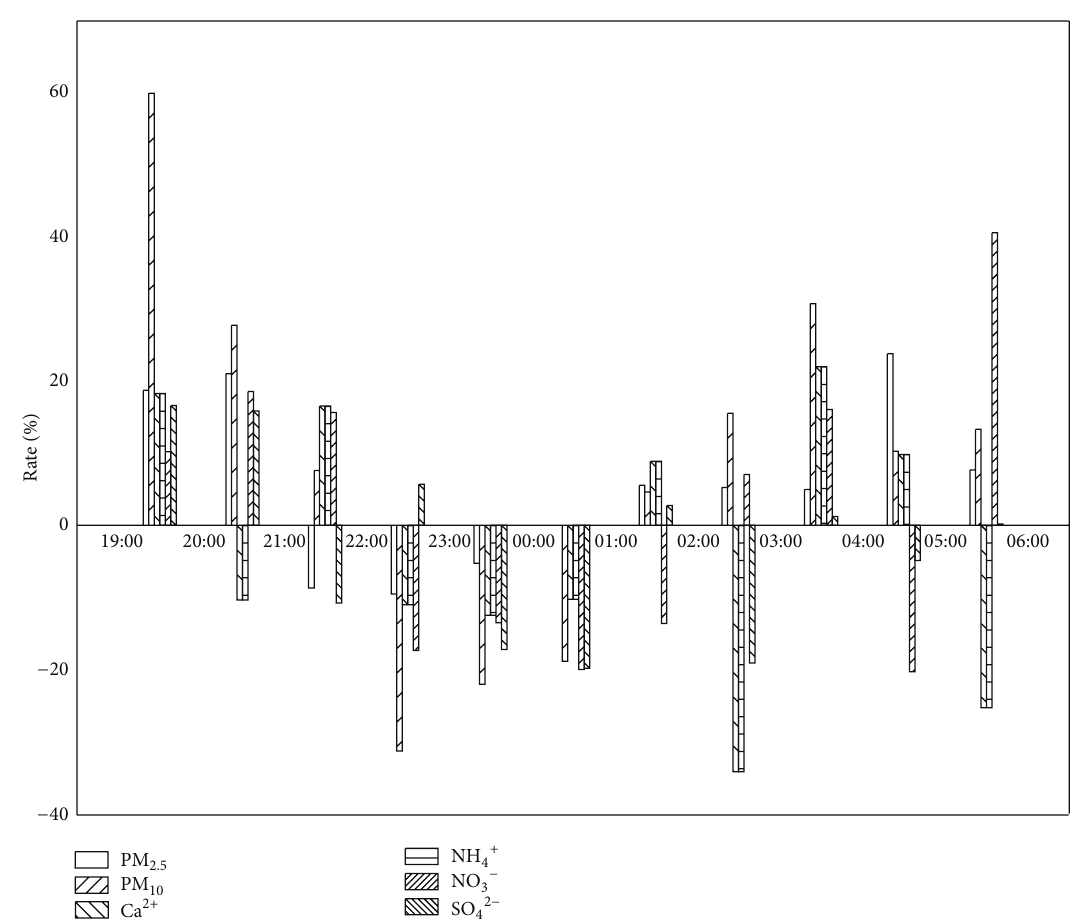
Figure 5: Hourly rate of concentration of ions, PM 10 , and PM 2.5 on 13-14 August,